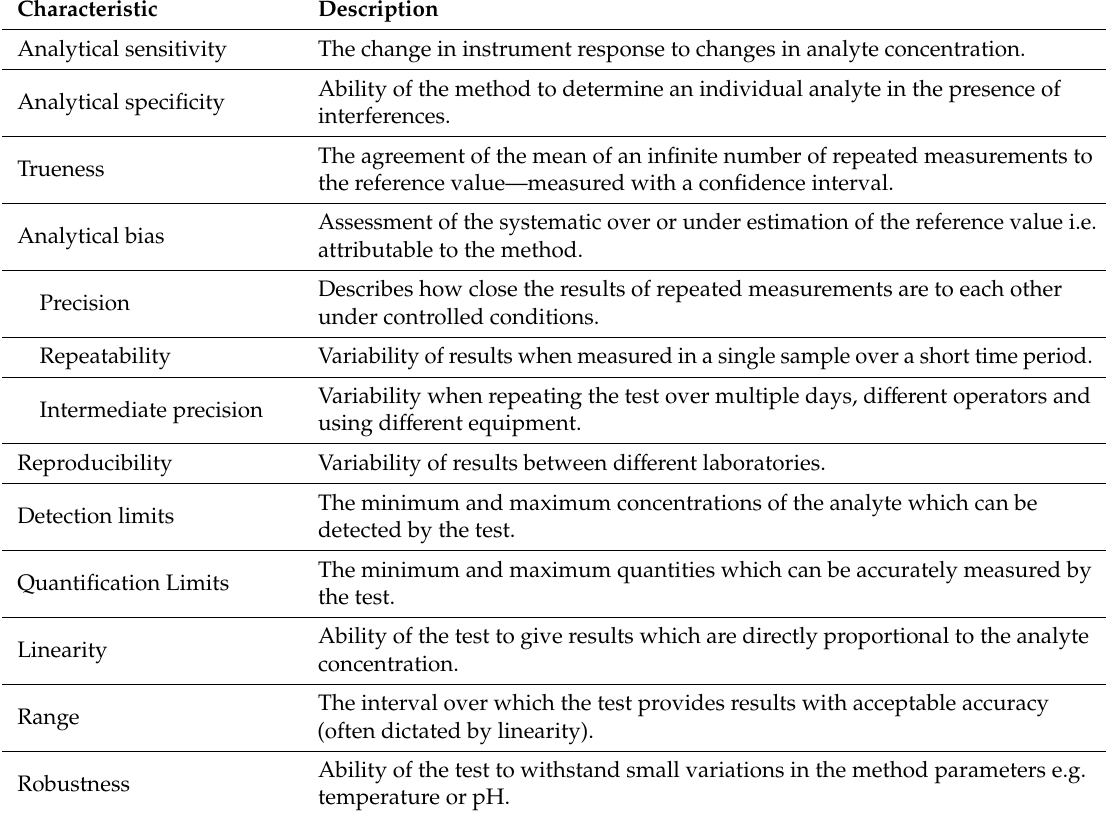
Table 2. Checklist of characteristics typically assessed in analytical validity